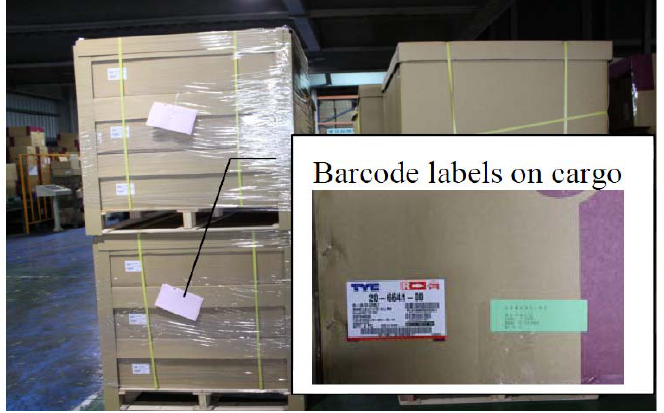
Figure 1. Traditional cargo tagged with dispatch list. Some of them are barcode-enabled, but others are not